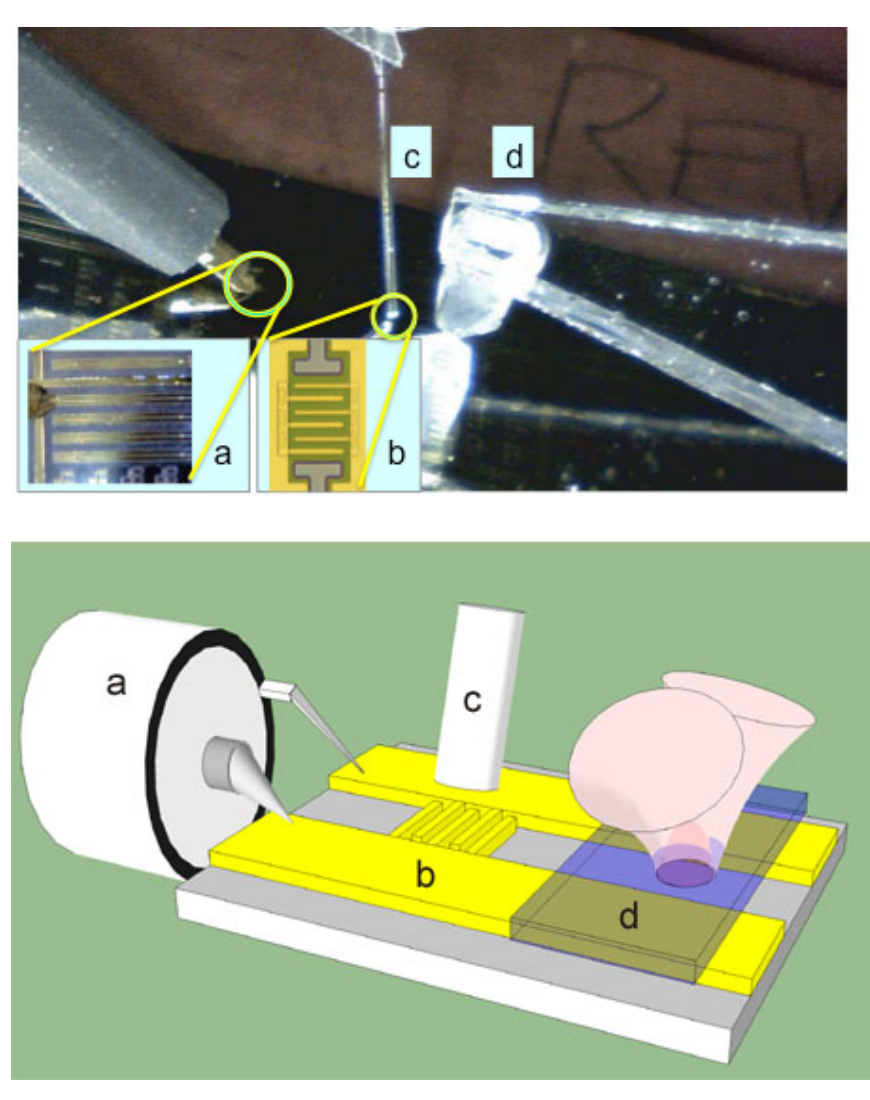
Figure 1. Image (top) and sketch (bottom) of the electro-optic sampling test setup highlight the ( a ) RF probe contacting the transmission line, ( b ) MSM photodetector, ( c ) optical fiber and ( d ) electro-optic crystal. The RF probe (a) is at one end of a transmission line, in the middle of which the interdigitated MSM device (b) is located. An inset shows an image of the fabricated device (b). The pump beam is delivered by an optical fiber (c) and the probe beam samples the propagating transient through the electro optic crystal